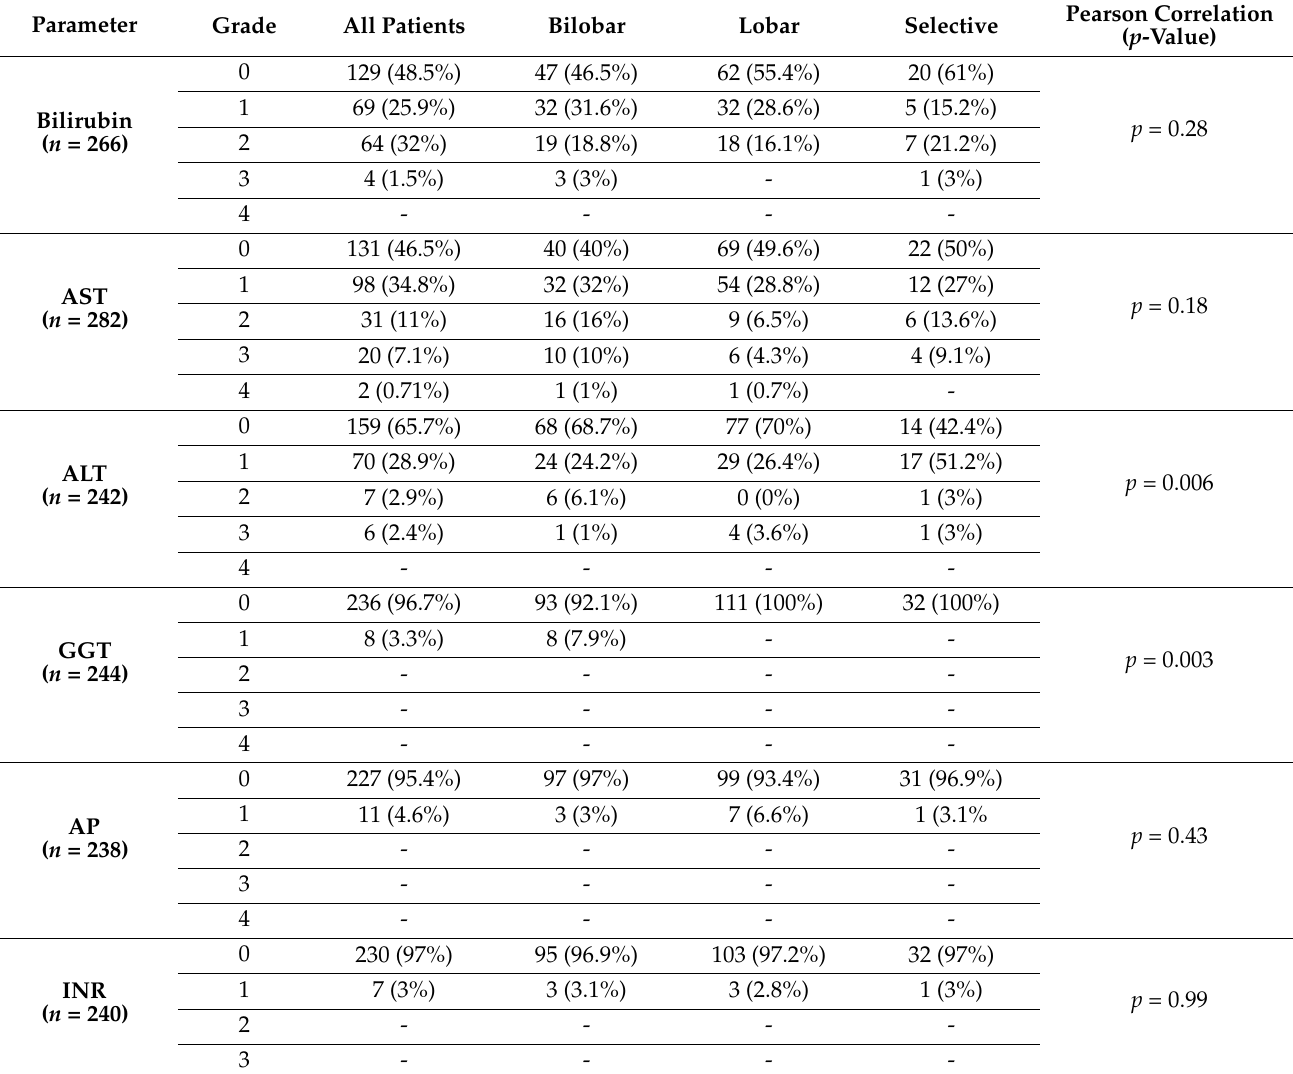
Table 5. Laboratory adverse